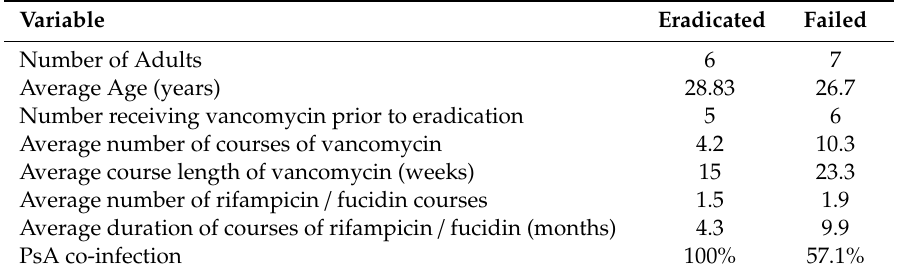
Table 3. Comparison of successful and failed MRSA eradication in those with complete data